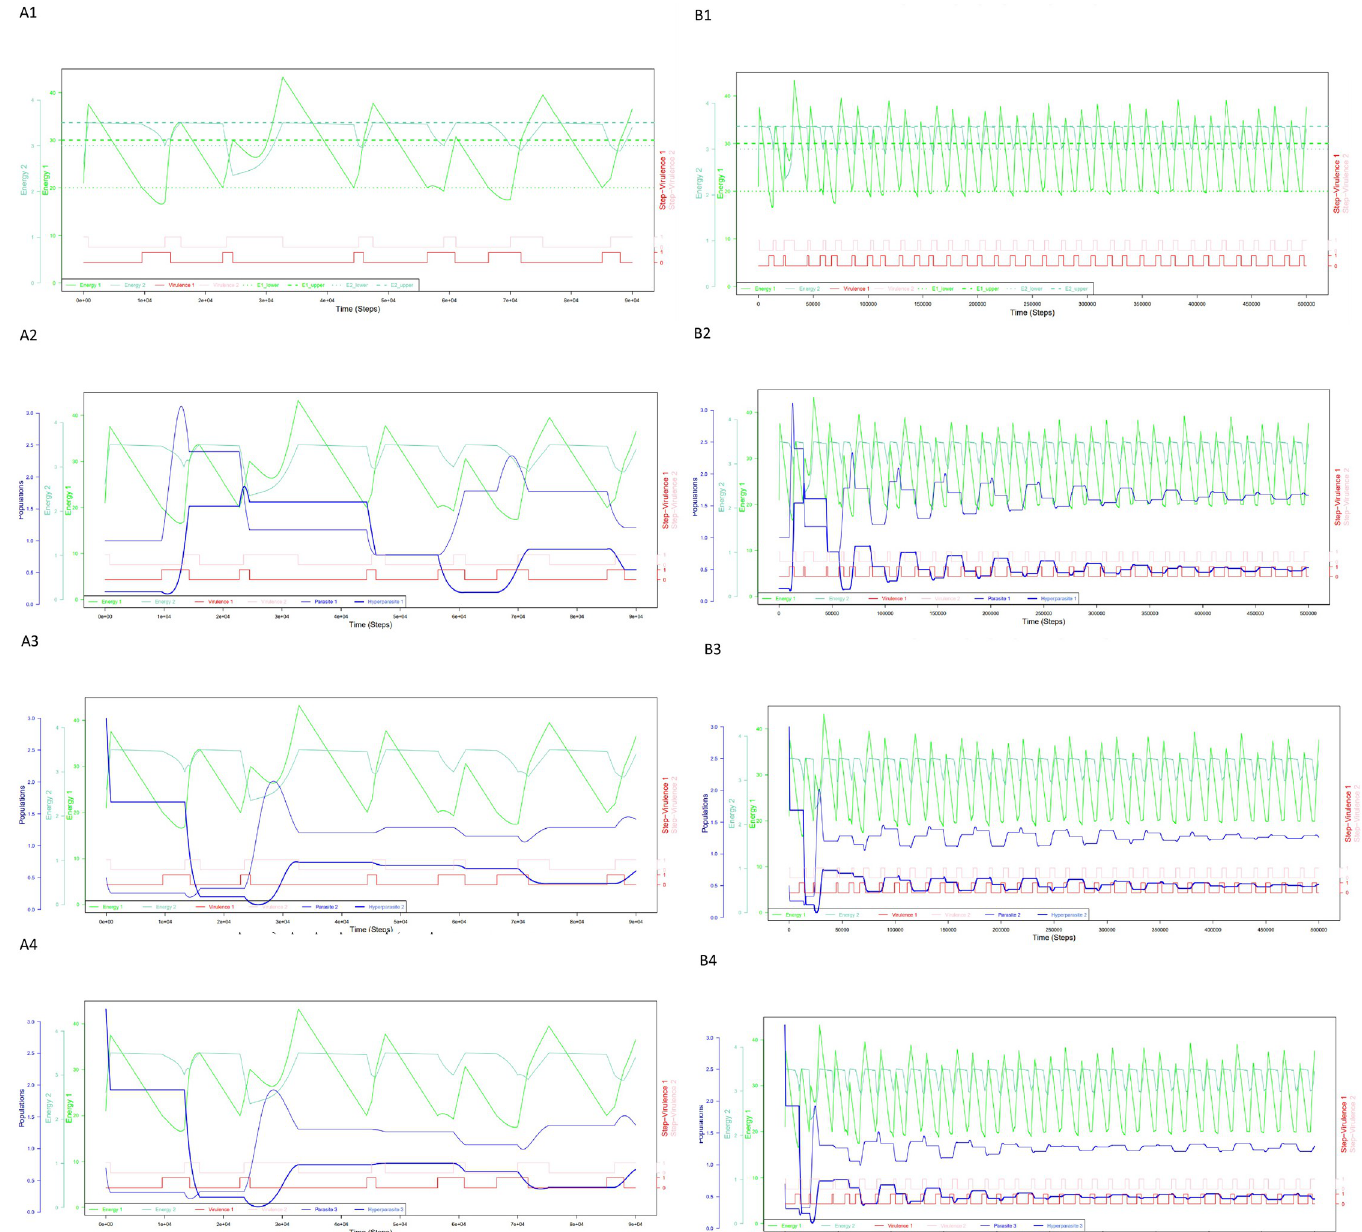
Fig 3. Two energies, three host-nested parasite units homeostasis model. (A1-A4) Represent the shorter (step 1, time 9e+04), and (B1-B4) the longer time scale (step 1, time 10e+05). The model is progressively extended by adding one, two and three host-parasite units ( X 1-3 , Y 1-3 ), and two energy levels ( E = E 1 , light green and E = E 2 , dark green). The viru-lence of ( X 1 , Y 1 ) is regulated by the operating energy E 1 ( X 2 , Y 2 ) and ( X 3 , Y 3 ) are E 2 – sensitive. (A1, B1) Show only two energies ( E 1 and E 2 ) and two virulences ( ν E 1 in red, ν E 2 in pink . (A2-A4, B2-B4) Show all three parameters simultaneously (population size in blue, parasites-hyper-parasites in light and dark blue, two energies and two virulences). (A2, B2) Display the parasite-hyperparasite pair ( X 1 , Y 1 ) responsible for E 2 ! E 1 transformation under virulence ν hyperparasite pair ( X 2 , Y 2 ) responsible for E 1 catalysis under virulence ν E 2 , and (A4, B4) the parasite-hyperparasite pair ( X 3 , Y 3 ) responsible for E 1 ! E 2 transformation under virulence ν E 2